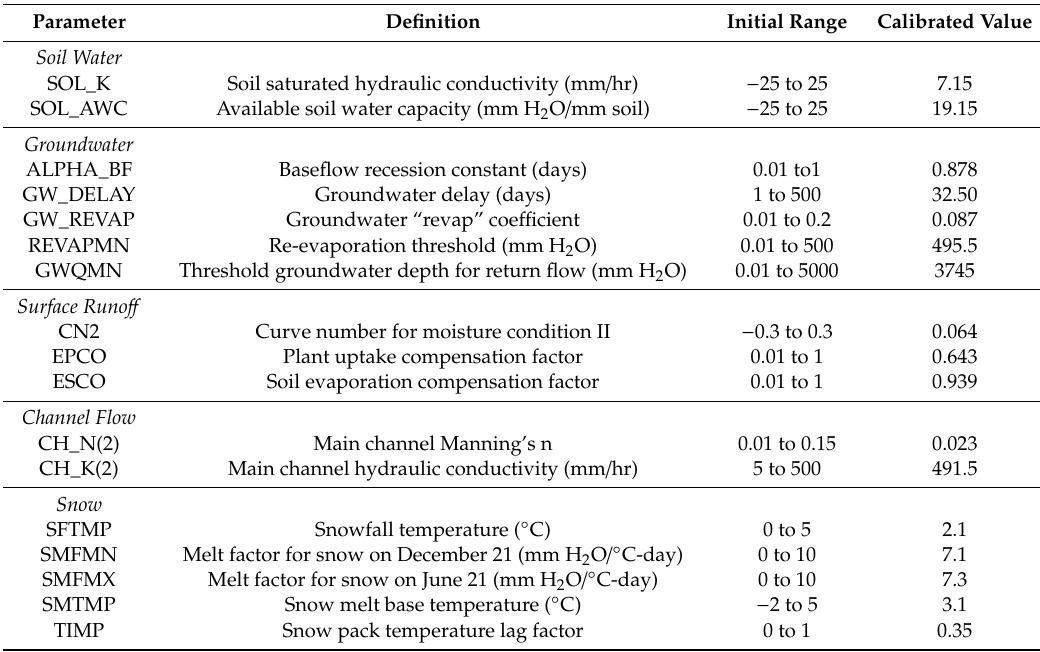
Table 3. The list of parameters used for model calibration for the study watershed.